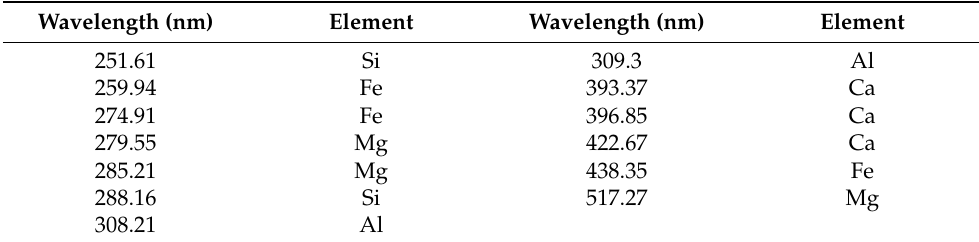
Table 5. List of emission lines considered for training/testing MLP